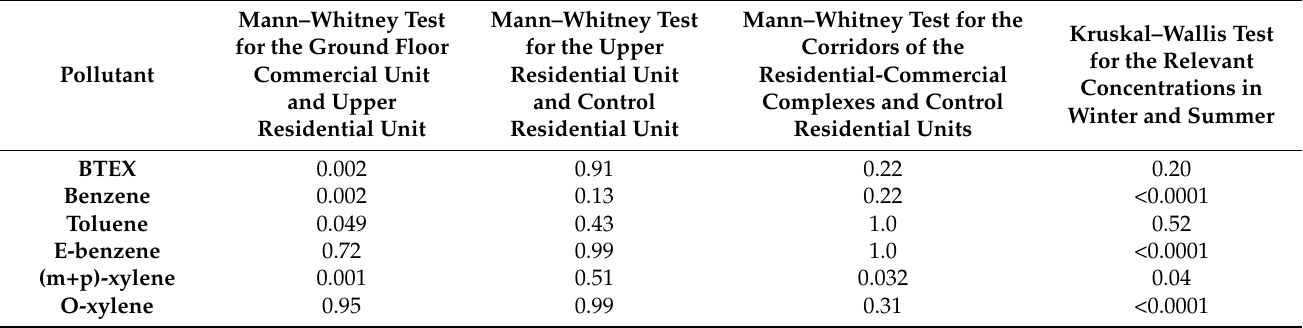
Table 3. The results of Mann–Whitney and Kruskal–Wallis tests for the compared